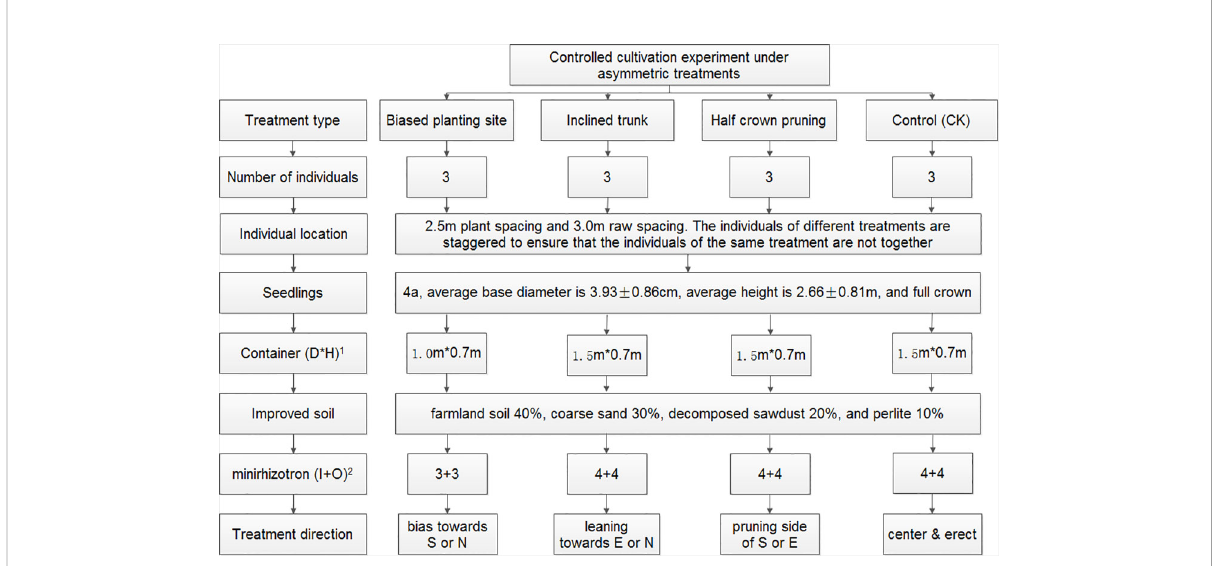
FIGURE 1 Experimental design of the controlled cultivation. 1 D is the diameter of container; H is the height of container; 2 I and O are the locations of the inner circle and outer circle of the minirhizotron tubes,